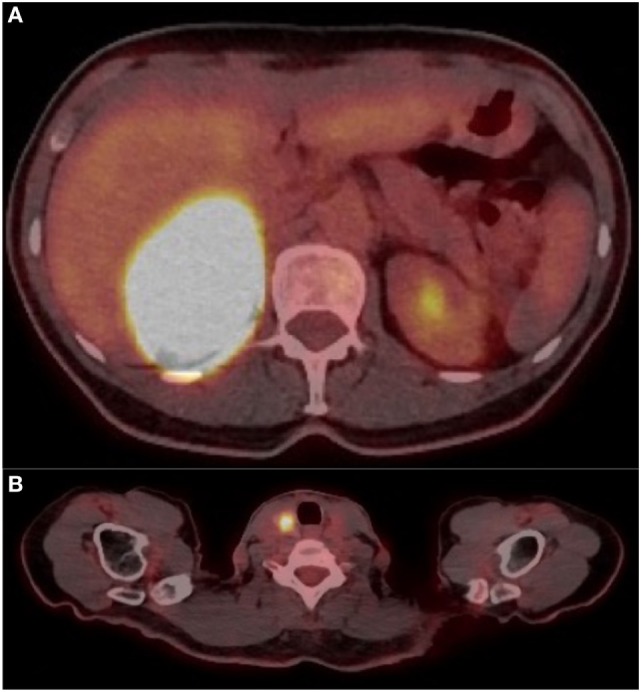
(A) Cross-sectional image on FDG positron emission tomography (PET) showing right adrenal mass at SUV max 88.7. (B) Cross-sectional image on FDG PET showing right thyroid mass at SUV max 10.6.